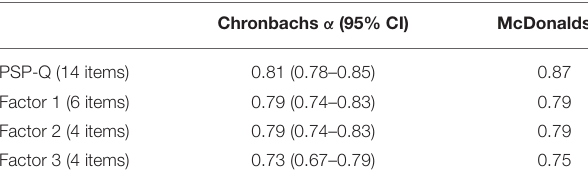
TABLE 4 | Chronbachs α of the PSP-Q and it